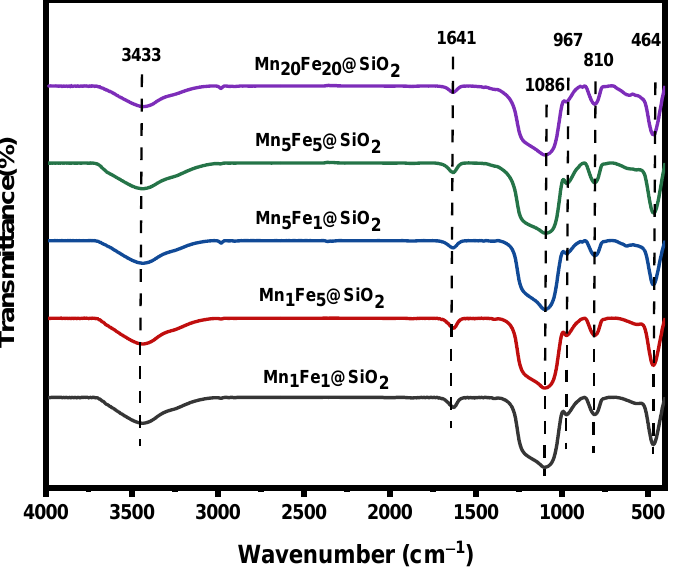
Figure 2. FTIR spectra of the synthesized nanocomposites. TGA: The thermal stability of the nanocomposites is shown in Figure 3. The samples